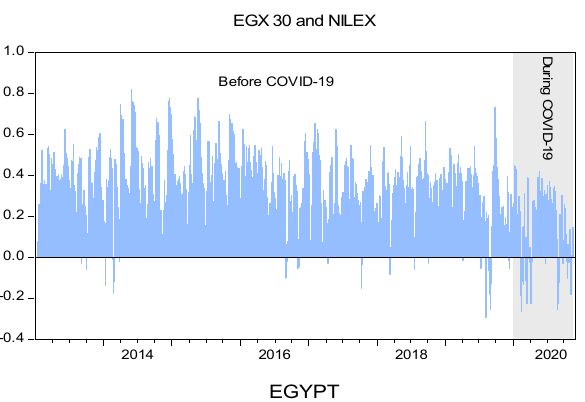
Figure 4. Dynamic conditional correlations between main and SME stock markets estimated from the asymmetric DCC–GARCH (1,1) model.